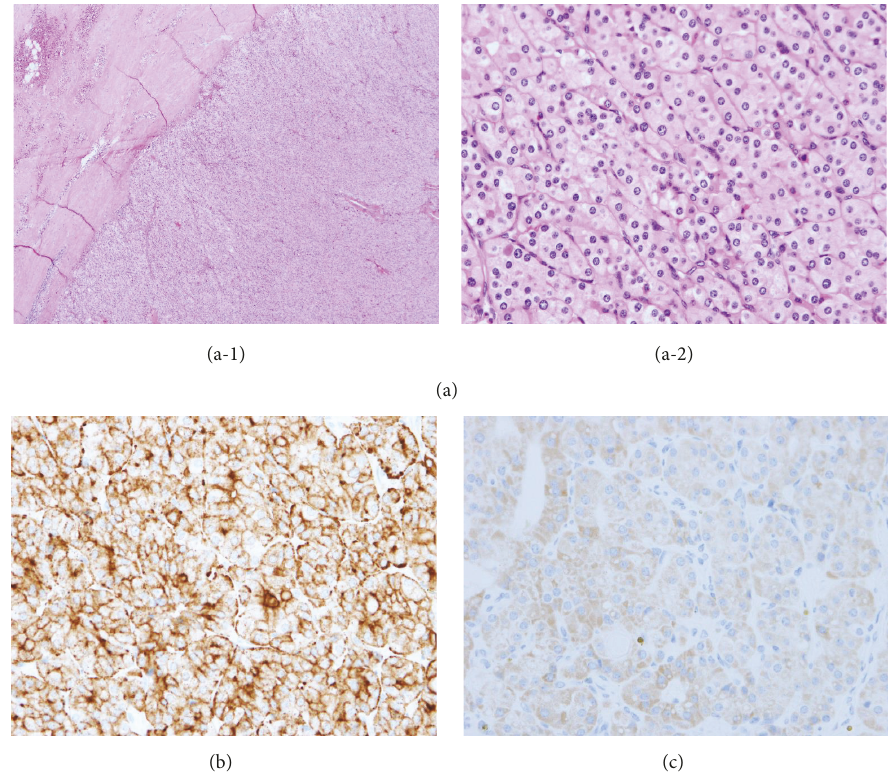
Figure2:(a)Hematoxylin-eosinstainedsectionsoftheadenoma(originalmagnification × 4(a-1)and × 40(a-2)).Theadenomawascomposed mainly of chief cells and oxyphil cells, covered with a fibrous capsule. No signs of malignancy, such as presence of capsular invasion, angioinvasion, and invasion of the surrounding structures, were observed. (b) Immunostaining for chromogranin A (brown precipitates). Section shows expression of chromogranin A. (c) Immunostaining for PTH (brown precipitates). Section shows expression of